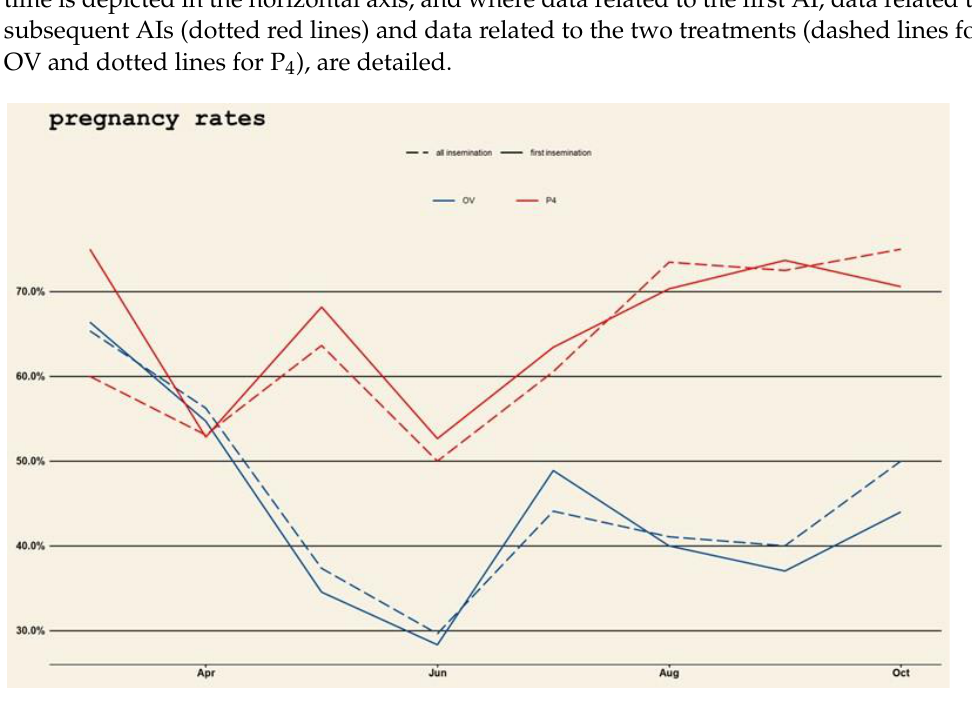
Figure 4. Descriptive analysis and tendency of pregnancies over months (horizontal lines), comparing the two treatments (dashed lines for Ovsynch (OV) and dotted lines for Progesterone based treatment (P 4 )) and the rates at first Artificial Insemination (dotted red lines) and subsequent inseminations (dashed lines for OV and dotted lines for P 4